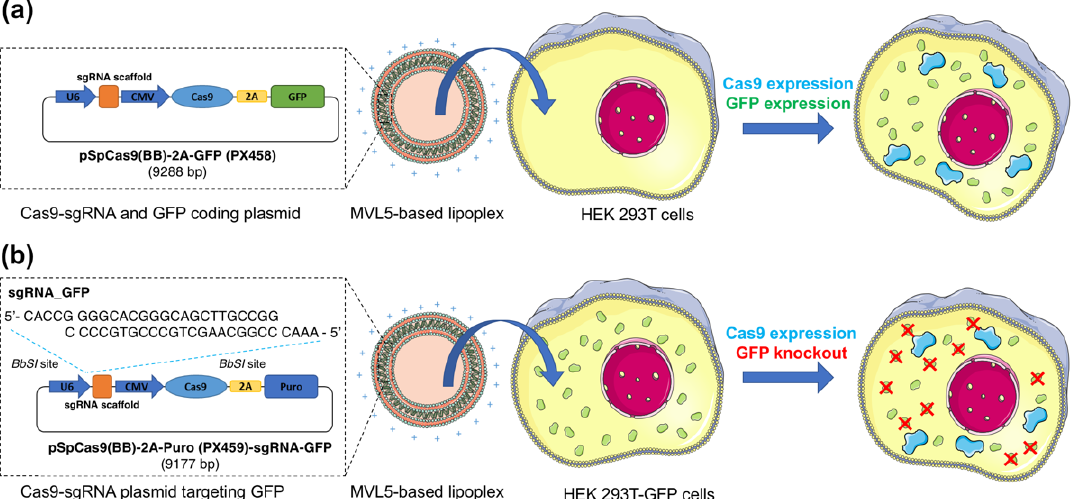
Figure 1. The experimental approach to study Cas9/sgRNA plasmid transfection and gene knockout. ( a ) A plasmid encoding both Cas9 and GFP cassettes is encapsulated into multivalent cationic lipid lipoplexes and administered to HEK 293T cells in vitro . The emergence of a green fluorescence signal in the cells, which indirectly indicates Cas9 expression, is detected by flow cytometry and fluorescence microscopy. ( b ) To measure CRISPR-mediated gene knockout, HEK 293T cells stably